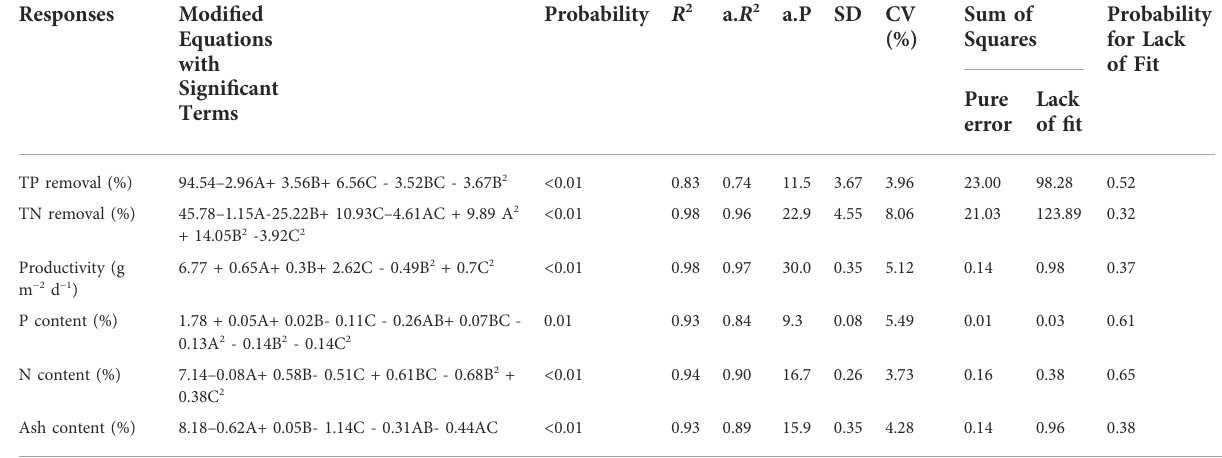
TABLE 3 Analysis of variance for the applied response surface model. TP, total phosphorus; TN, total nitrogen; A, total inorganic carbon (TIC); B, nitrogen-to-phosphorus ratio (N:P ratio); C, light intensity; R 2 , determination coef fi cient; a. R 2 , adjusted R 2 ; a.P., adequate precision; SD, standard deviation; CV, coef fi cient of